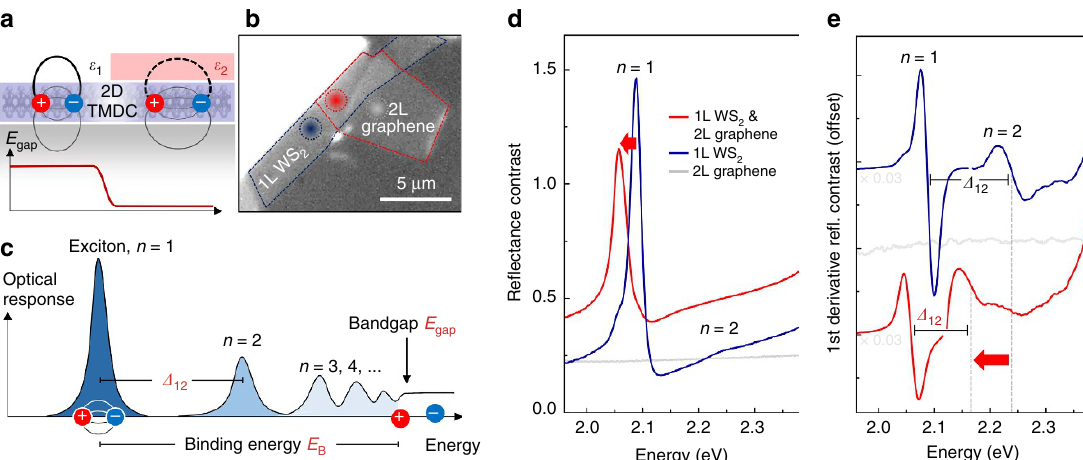
Figure 1 | Engineering Coulomb interactions through environmental screening. ( a ) Schematic illustration of a semiconducting 2D TMDC material, partially covered with an ultra-thin dielectric layer. The strong Coulomb interaction between charged particles in low-dimensional systems affects both the exciton binding energy and the quasiparticle bandgap. The interaction can be strongly modified by modulating the environmental dielectric screening on atomic length scales. ( b ) An optical micrograph of the heterostructure under study: monolayer WS 2 covered with a bilayer of graphene. Dotted circles indicate positions for the optical measurements. ( c ) Illustration of the optical response of an ideal 2D semiconductor, including exciton ground and excited state resonances and the onset of the (quasiparticle) bandgap. ( d ) Reflectance contrast spectra of the bare bilayer graphene, monolayer WS 2 and the resulting WS 2 /graphene heterostructure at a temperature of 70K. ( e ) First derivatives of the reflectance contrast spectra in d (after averaging over a 20meV interval), offset for clarity. Peak positions of the exciton ground state ( n ¼ 1) and the first excited state ( n ¼ 2) resonances, roughly corresponding to the points of inflection, are indicated by dashed lines; D 12 denotes the respective energy separations. The observed decrease of D 12 across the in-plane boundary of the heterostructure is indicative of a reduction of the exciton binding energy and bandgap by more than 100meV due to the presence of the adjacent graphene